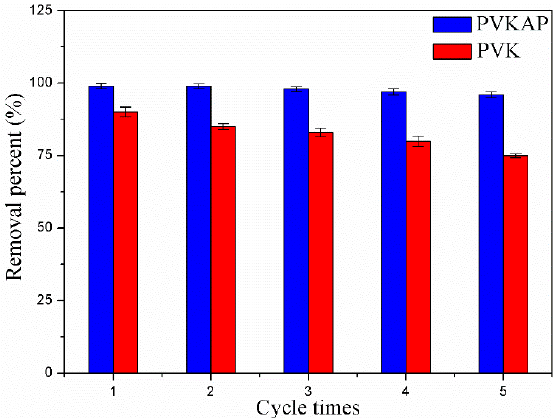
Figure 8. Reusability studies of PVK and PVKAP on the removal of U(VI) from aqueous solution, T = 293 K, pH = 5.0 ± 0.1, C U(VI)initial = 36.0 mg L − 1 , m/V = 0.1 g L − 1 .